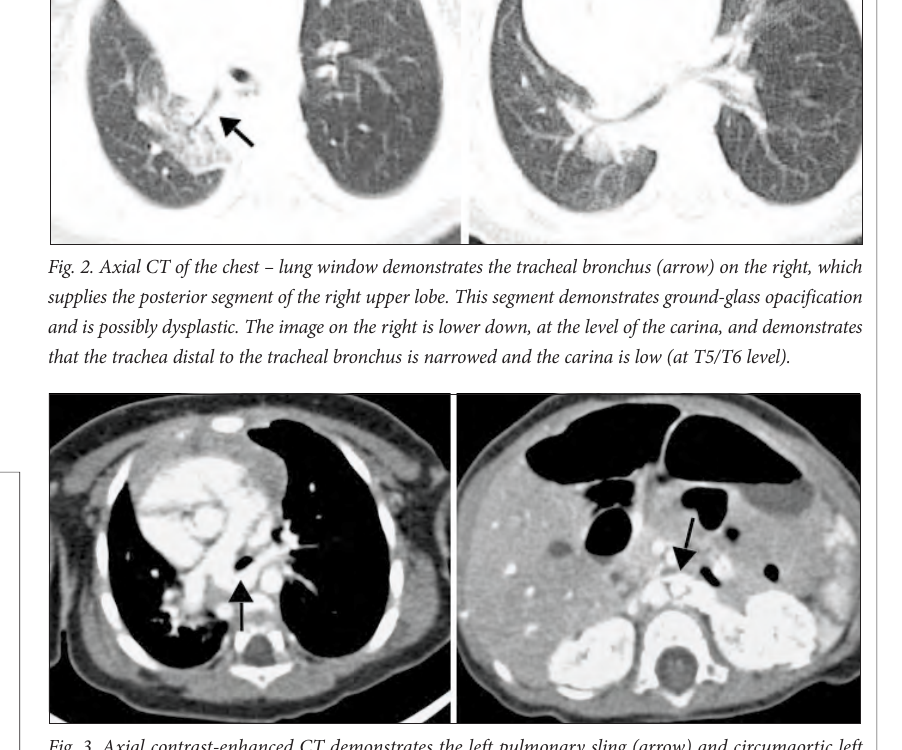
Fig. 3. Axial contrast-enhanced CT demonstrates the left pulmonary sling (arrow) and circumaortic left renal vein